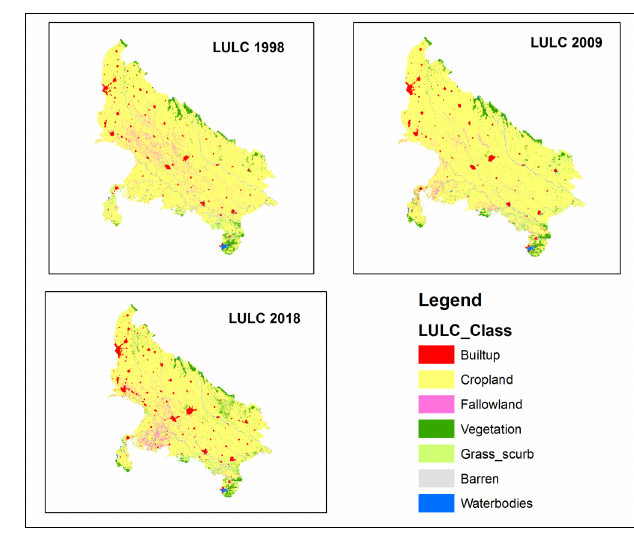
Figure 2. Classified map of UP using SVM-RBF